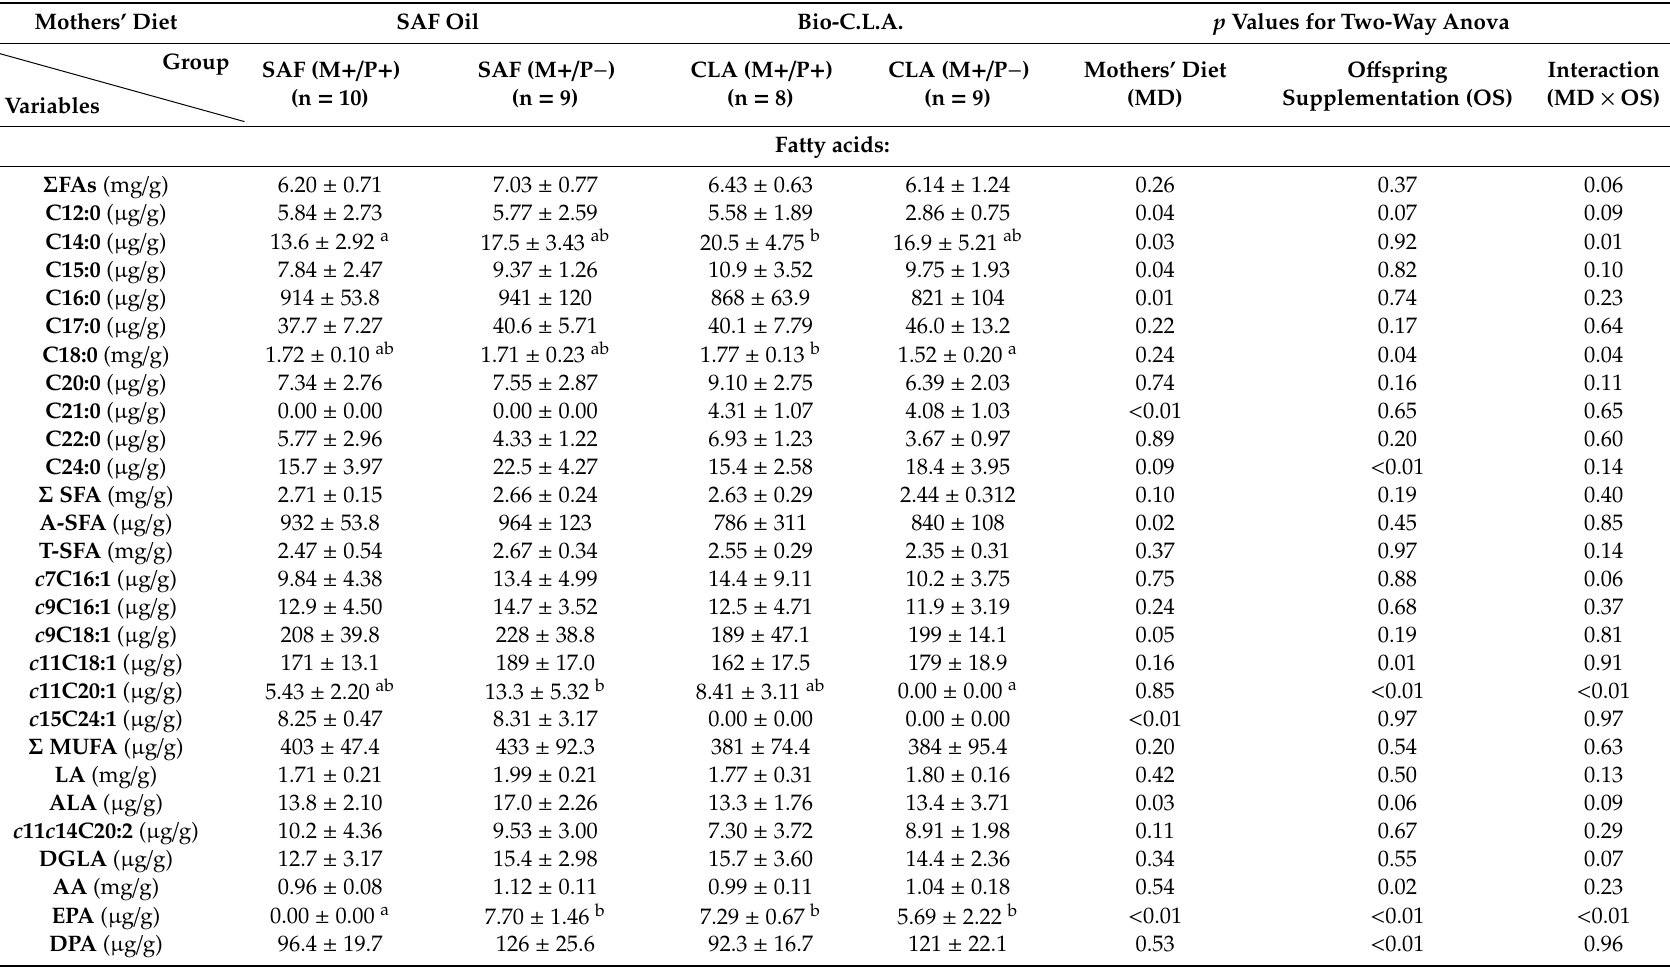
Table 2. Profile of fatty acids (FA) in hearts of the o ff spring of mothers supplemented with sa ffl ower oil (SAF oil) or Bio-C.L.A., in whom supplementation with the same preparation was continued (SAF(M +/ P + ); CLA(M +/ P + )) or not (SAF(M +/ P − ); CLA(M +/ P − )). Mothers’ Diet SAF Oil Bio-C.L.A. p Values for Two-Way